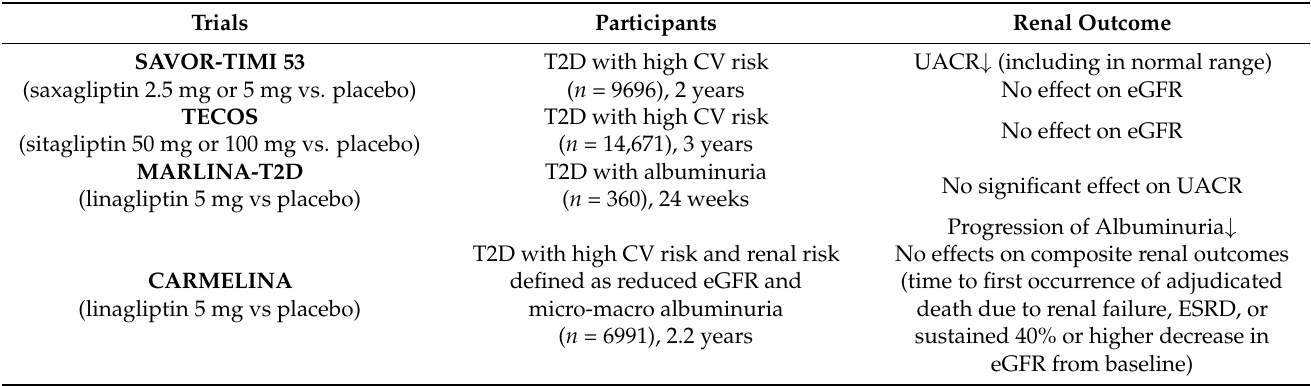
Table 1. Renal outcomes of major clinical trials using DPP-4 inhibitors. The beneficial effects of DPP-4 inhibitors on albuminuria but not the reduction in the estimated glomerular filtration rate are shown. Trials Participants Renal